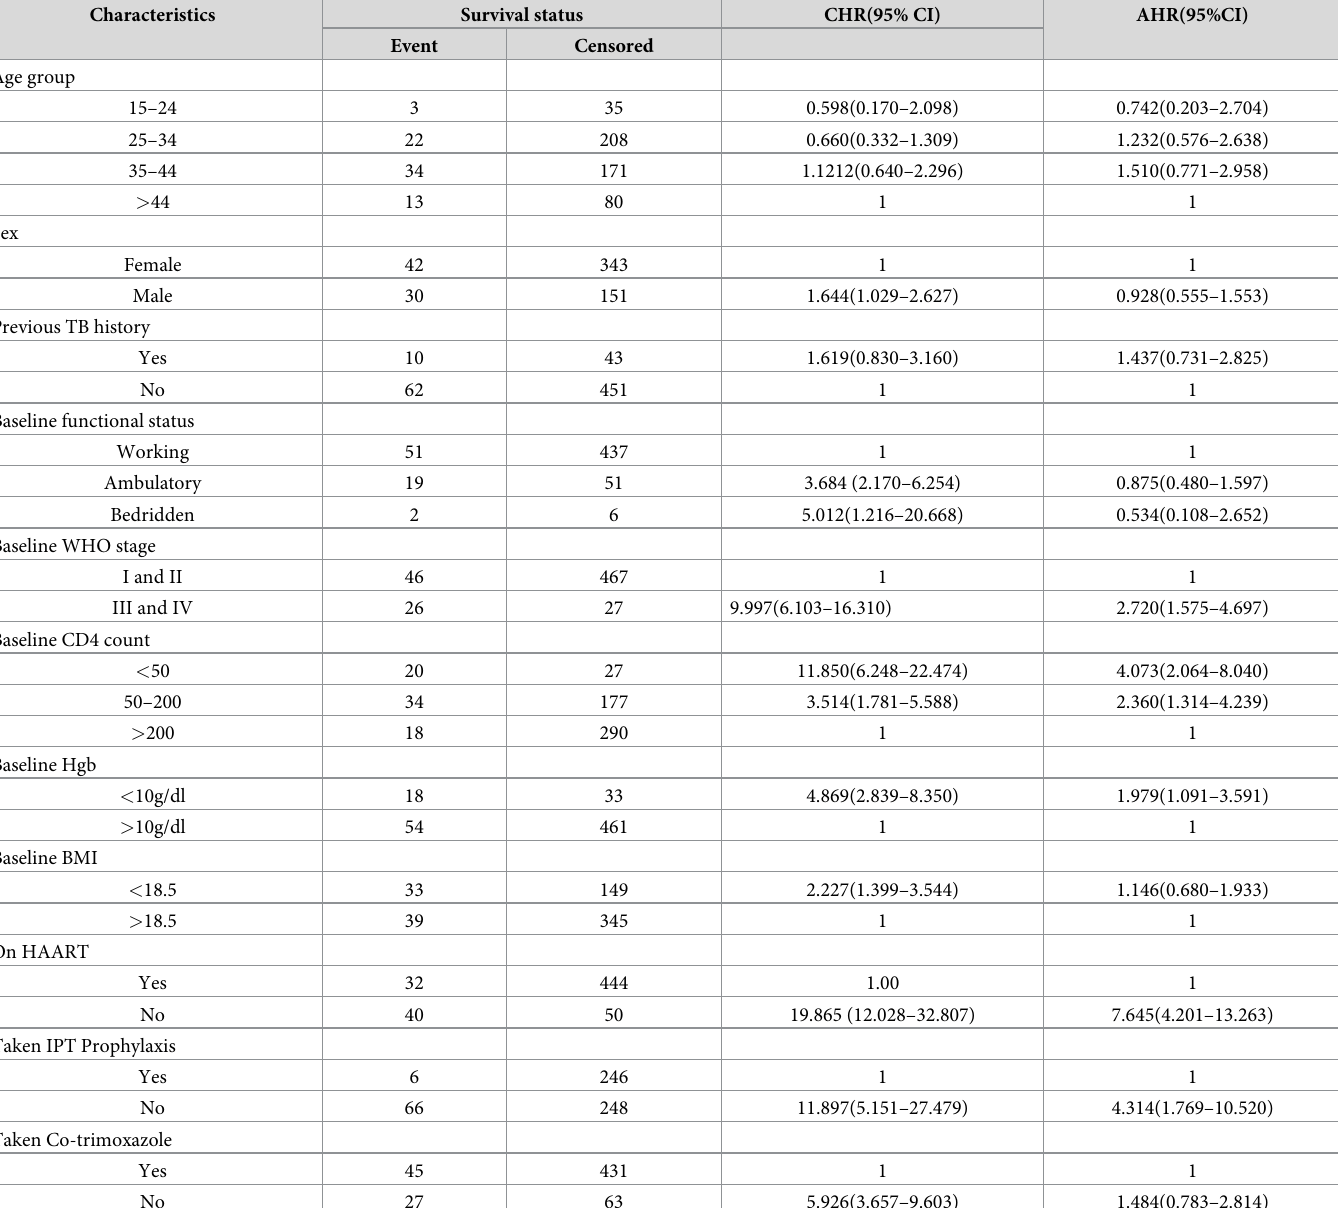
Table 4. Bi-variable and multi-variable Cox regression analysis of extrapulmonary tuberculosis among HIV positive patients in Addis Ababa, Ethiopia, from 01 January 2013 up to 31 December 2018 (n = 566).